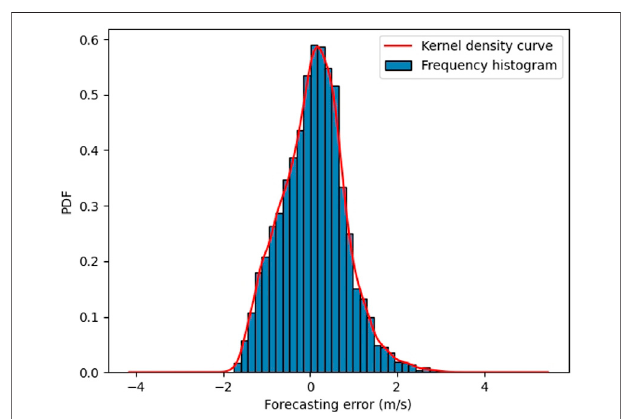
FIGURE 9 | PDF of predicted error within autumn.